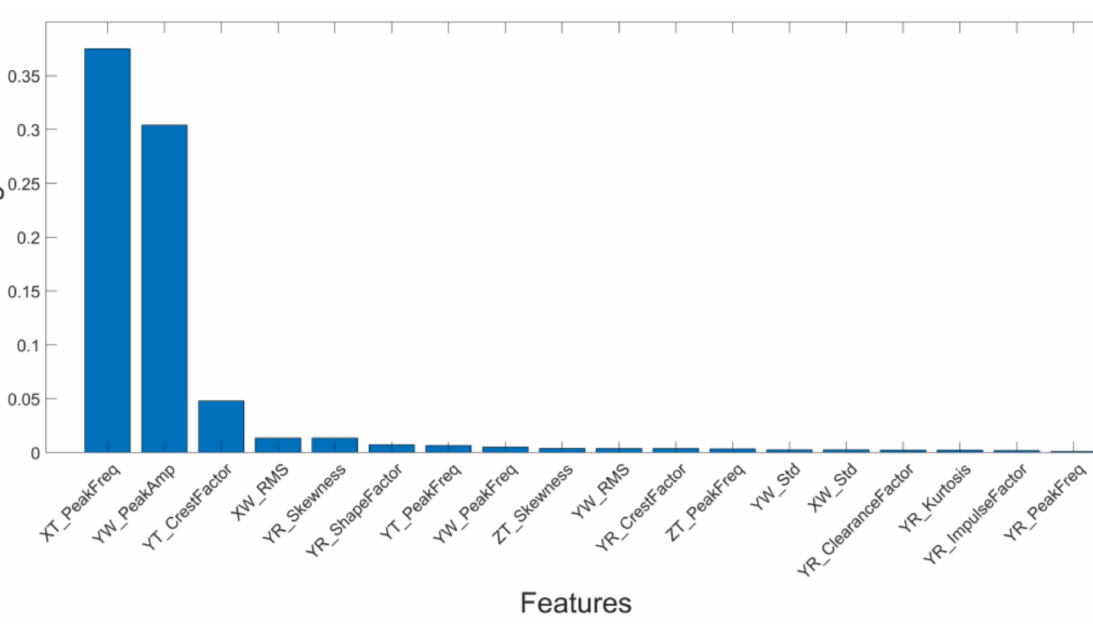
Figure 4. Significance ranking of features that satisfied the condition of the most significant applica- bility with minimal redundancy. Obtained from pump body vibration